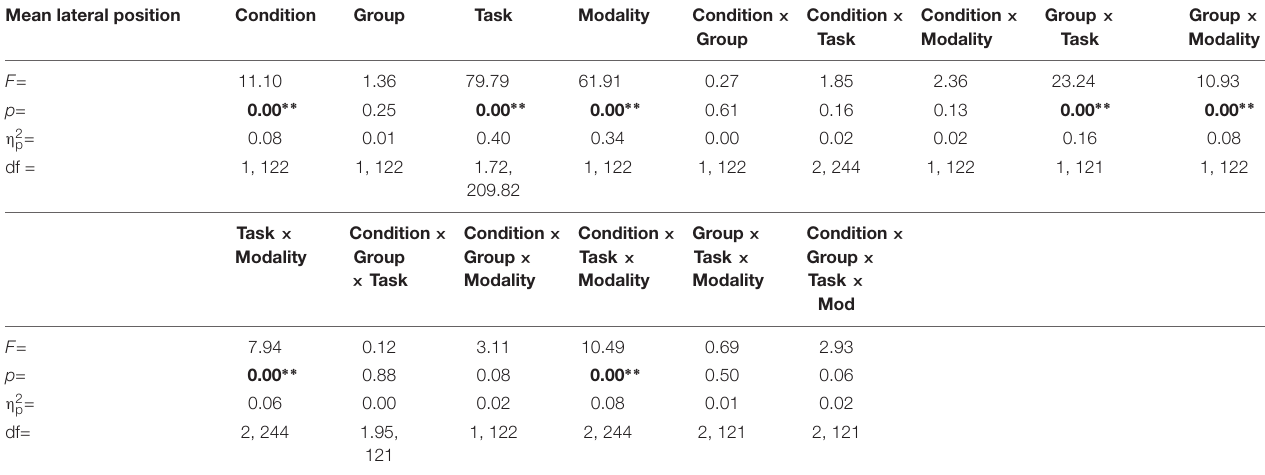
TABLE 3 | ANOVA results for mean lateral position . Mean lateral